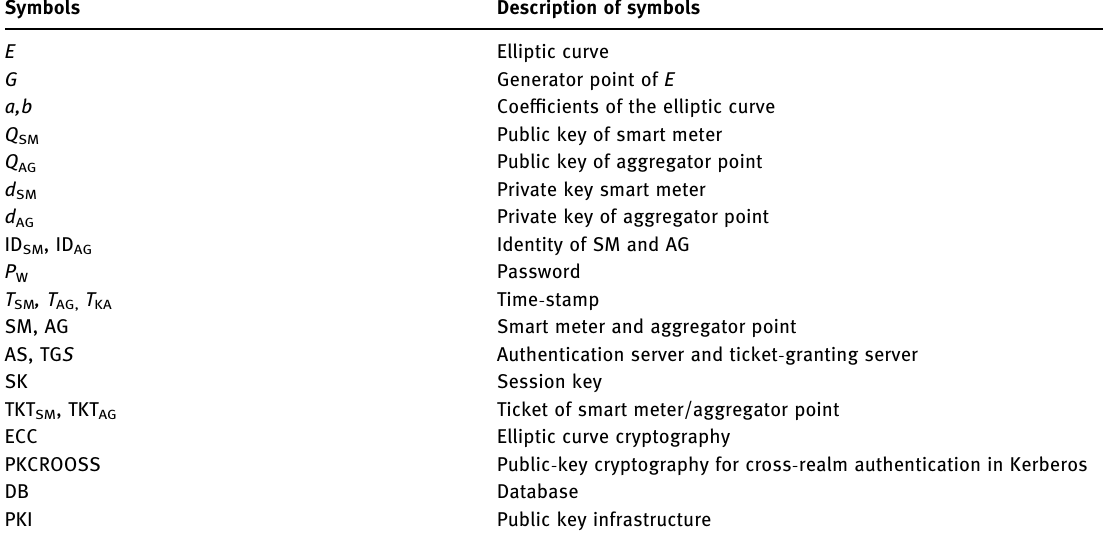
Table 1: List of symbols Symbols Description of